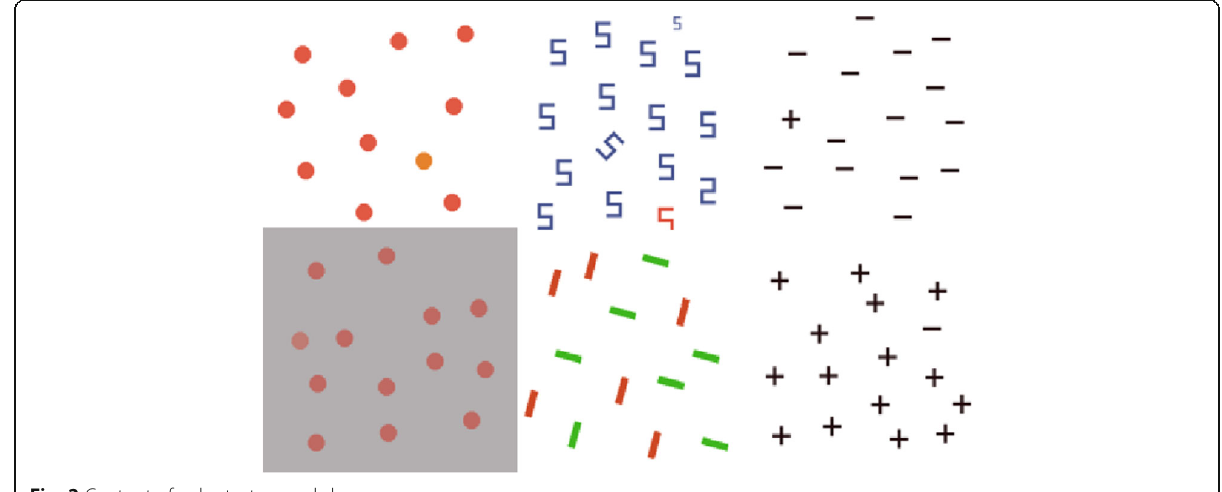
Fig. 2 Contrast of color texture and shape